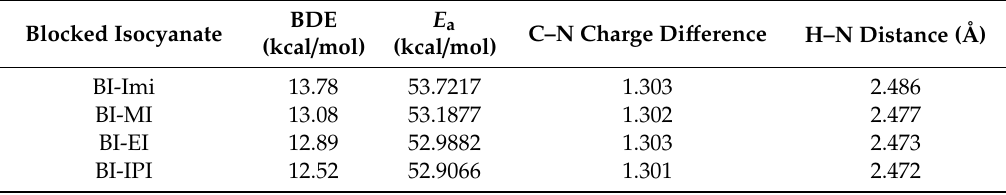
Table 2. Calculated BDE, E a , C–N charge difference, and H–N distance for imidazole-Bis. Blocked Isocyanate